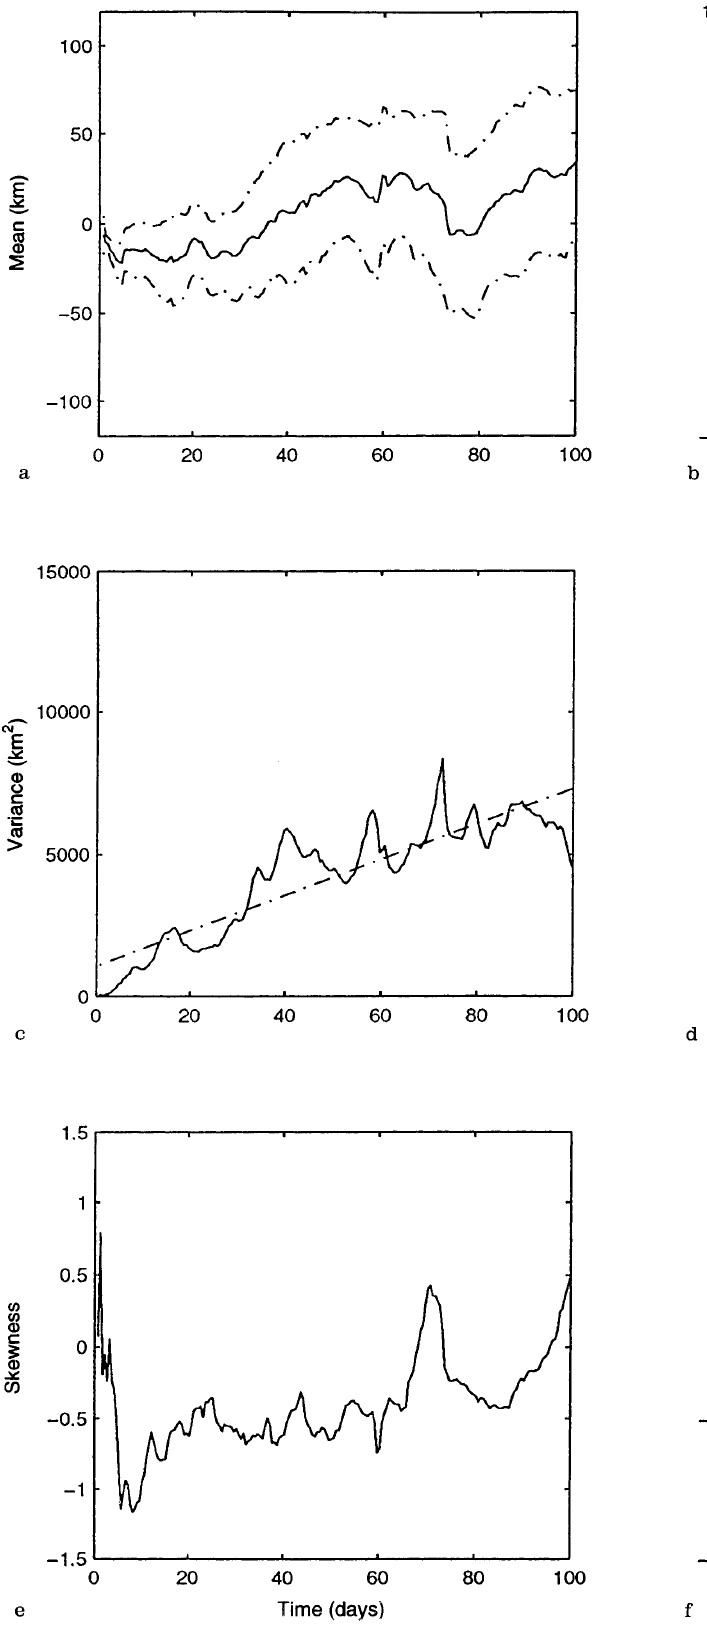
Fig. 14a–f. Summary statistics describing dispersion during summer along the two axes; X across-slope distance from the 500 m contour, and Y along-slope distance from deployment, as in Fig. 13. a, b Mean